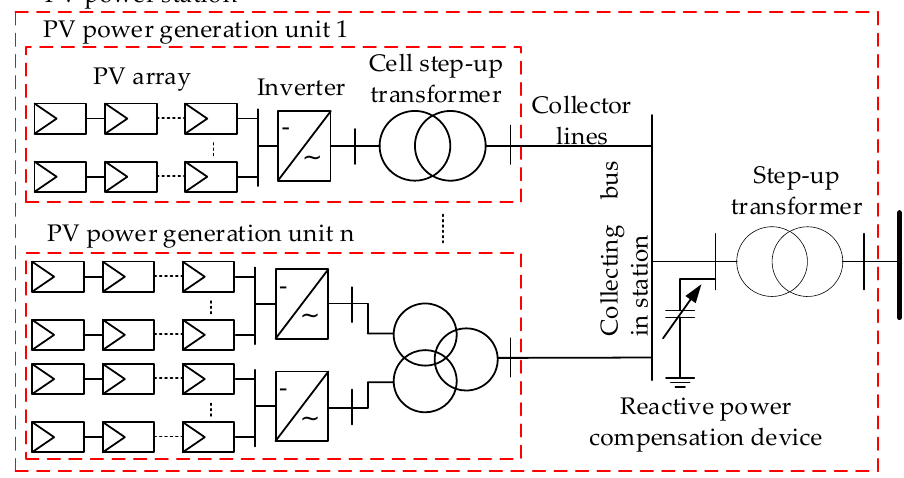
Figure 1. Typical structure of a photovoltaic (PV) power station.